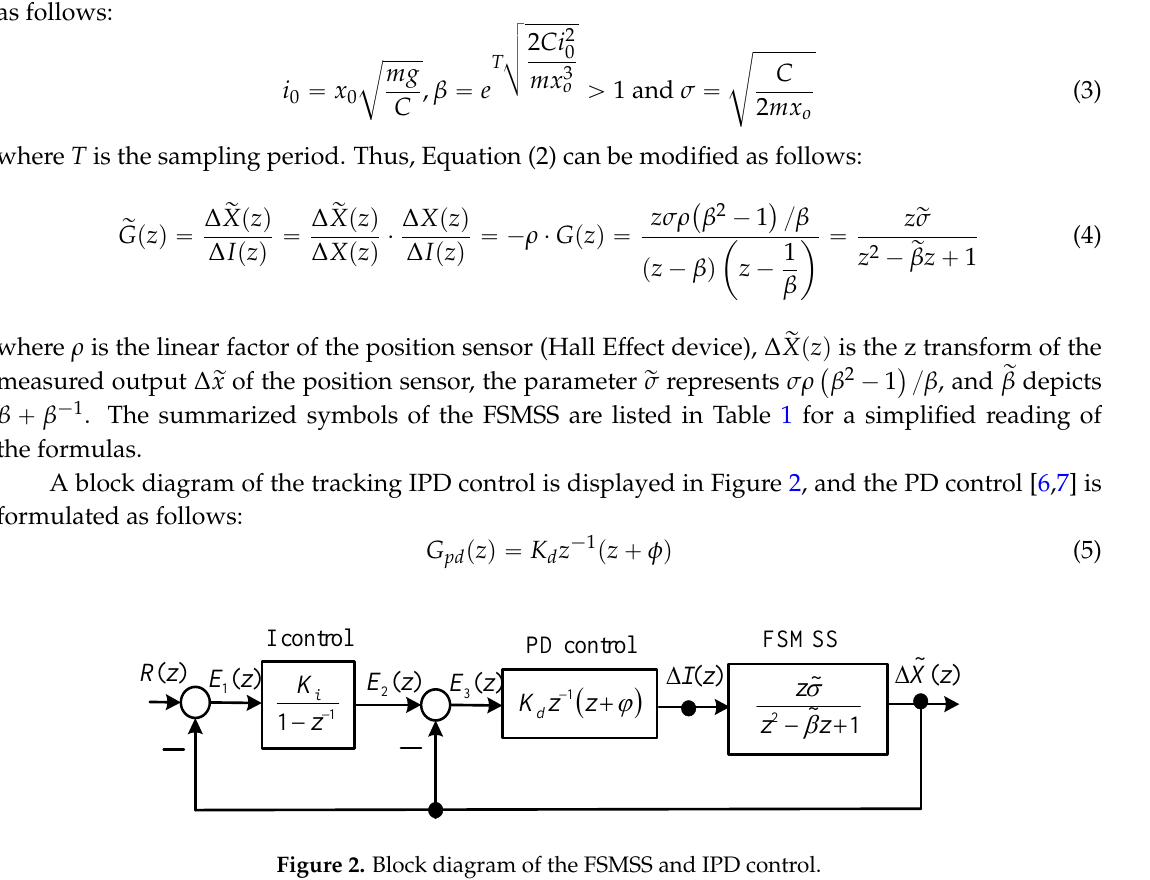
Figure 2. Block diagram of the FSMSS and IPD control. The stable conditions of